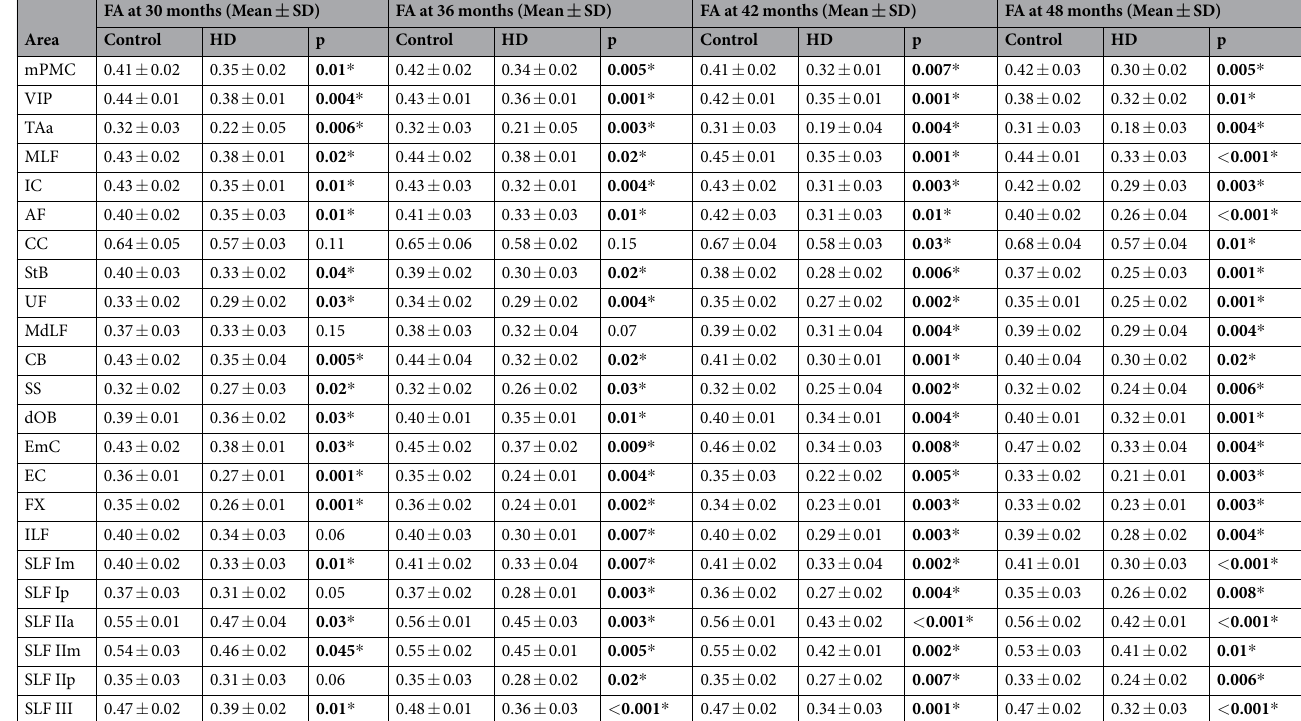
Table 4. FA group difference at ages from 30 to 48 months. The data were tested with a two-way ANOVA and post-hoc analysis with significant level of p < 0.05 ( * ). SD: standard derivation. FA: fractional